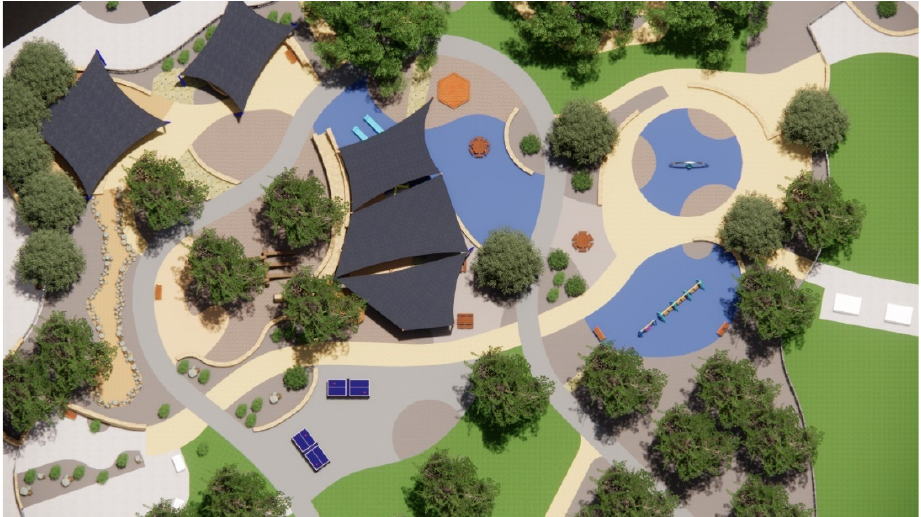
Figure 16. Shade sails, unshaded children’s play areas, and picnic tables during midday on the summer solstice.